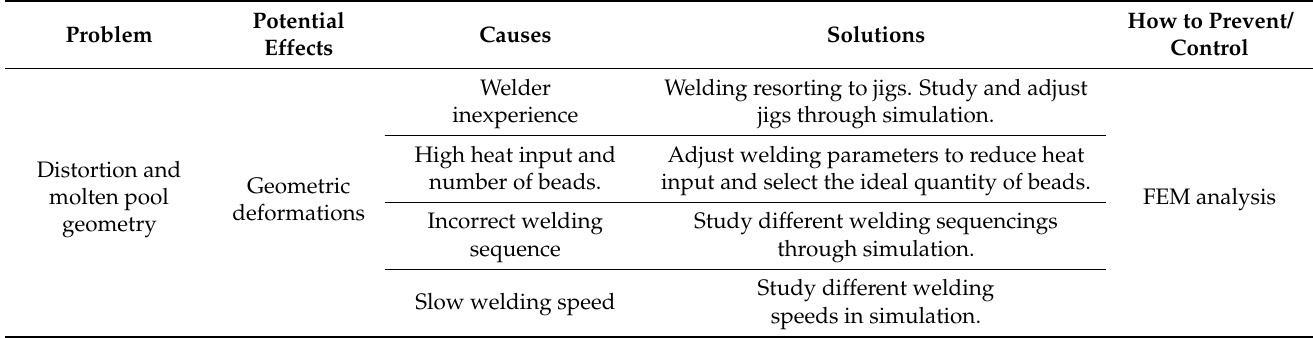
Table 1. How to prevent laser welding defects—pre-welding